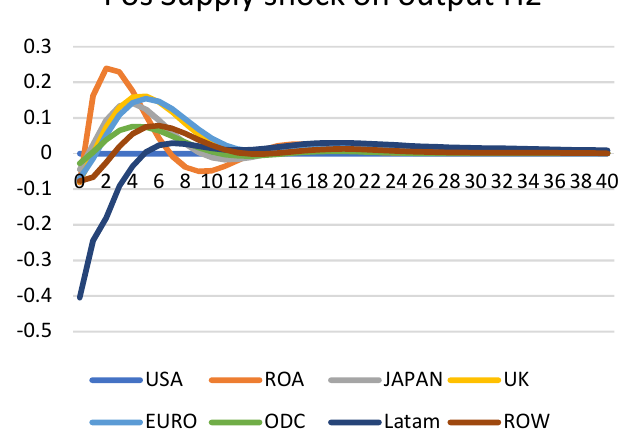
Figure 6. Positive supply shock on